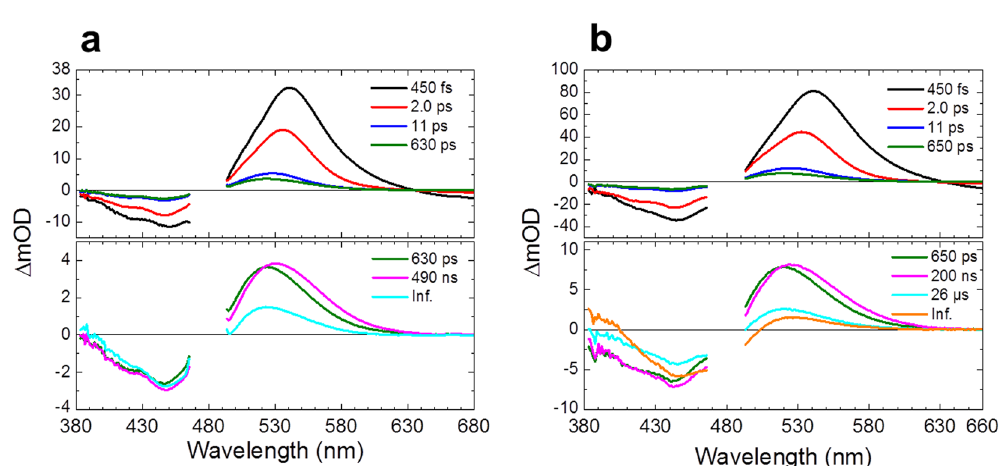
Figure 1. Close-up of the retinal binding pocket of C1C2 13 (PDB ID: 3UG9).